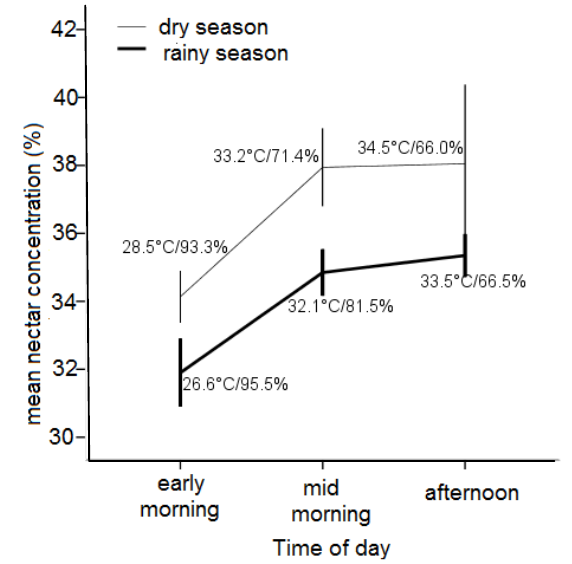
F IG . 1. Daily and seasonal variation of nectar concentration of Luffa aegyptiaca . Insert: average temperature (°C) and relative